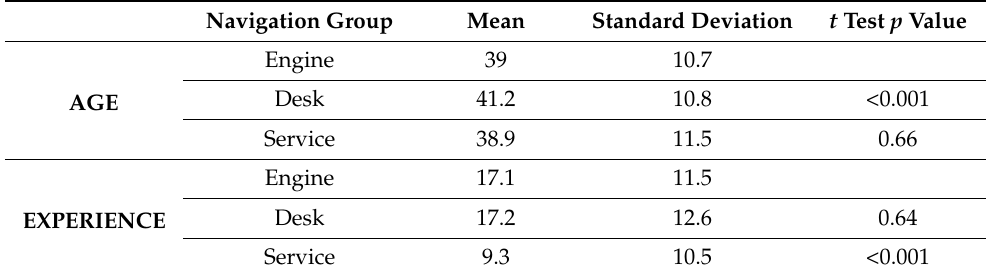
Table 2. Mean of age and experience in years of included